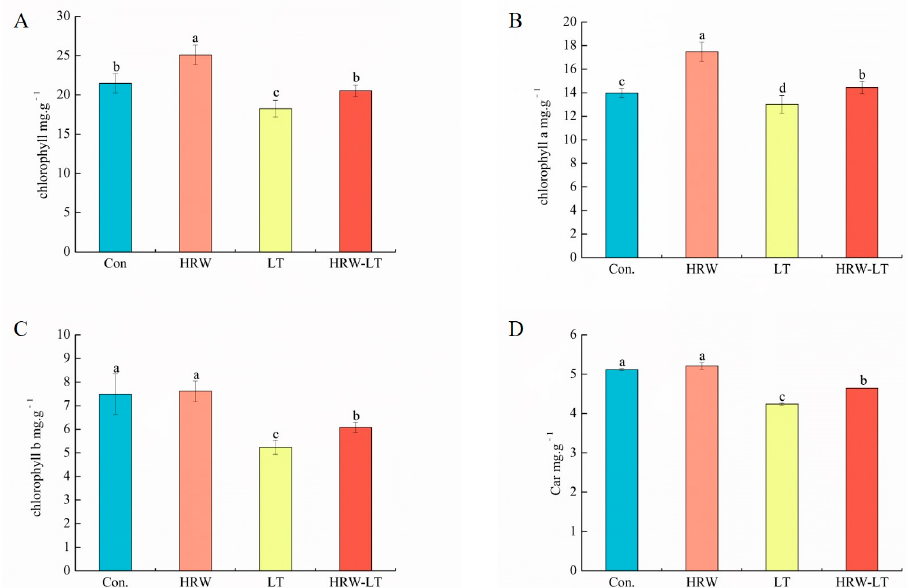
Figure 4. Effect of HRW on pigment content of cucumber seedlings under chilling stress. ( A ) chlorophyll; ( B ) chlorophyll a; ( C ) chlorophyll b.;( D ) car. Data are the mean ± standard de- viation of three biological replicates. The different letters indicate a significant difference ( p < 0.05). These indicators were measured after 72 h of chilling